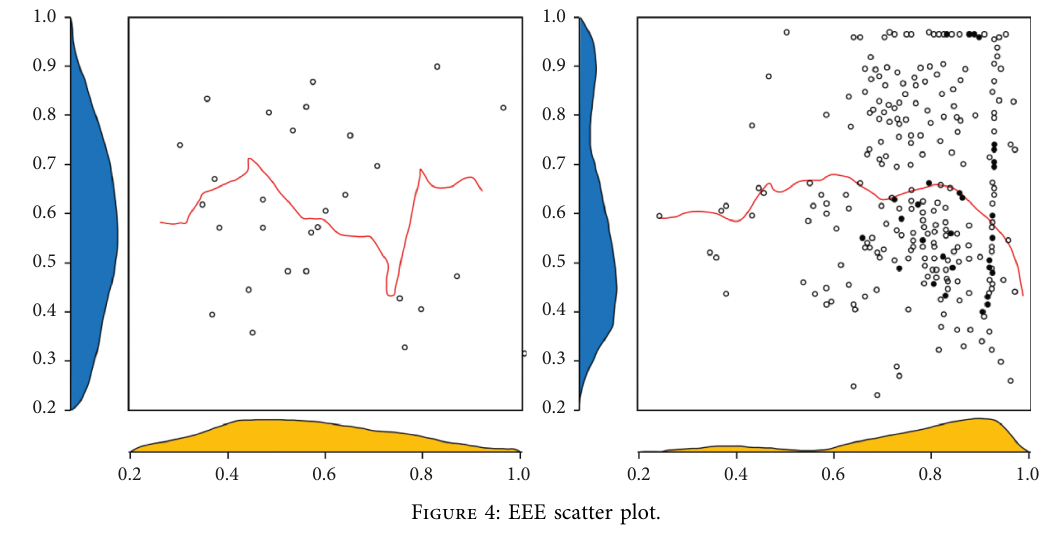
Figure 4: EEE scatter